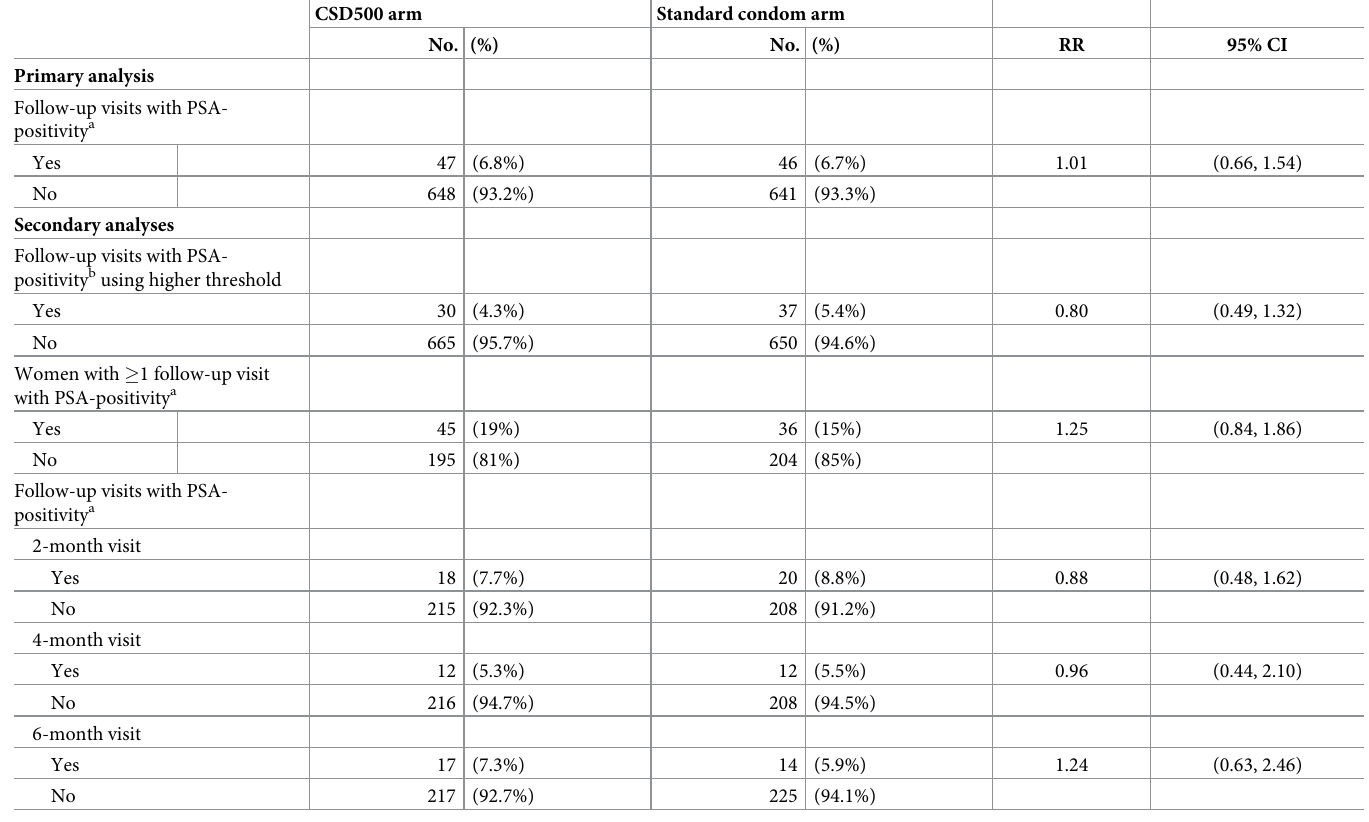
Table 3. PSA-positivity at follow-up by study arm for intent-to-treat population (N =